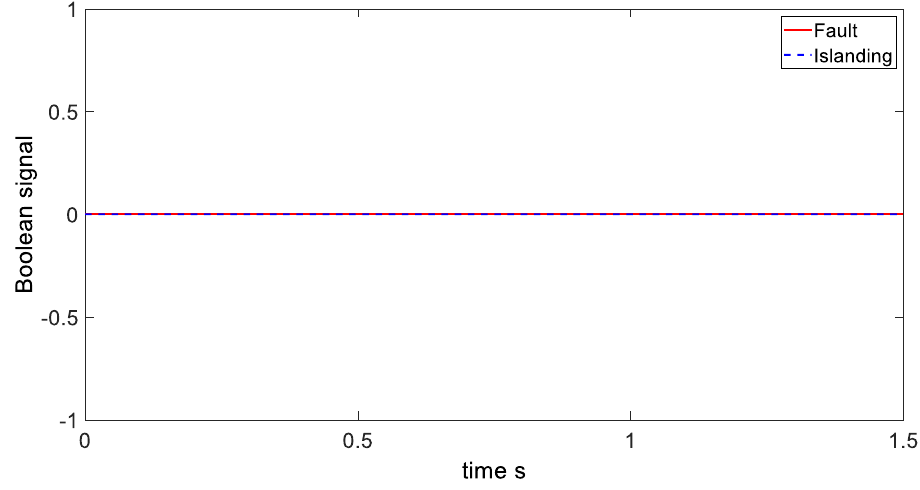
Figure 13. Islanding and fault detection signal for case 4.